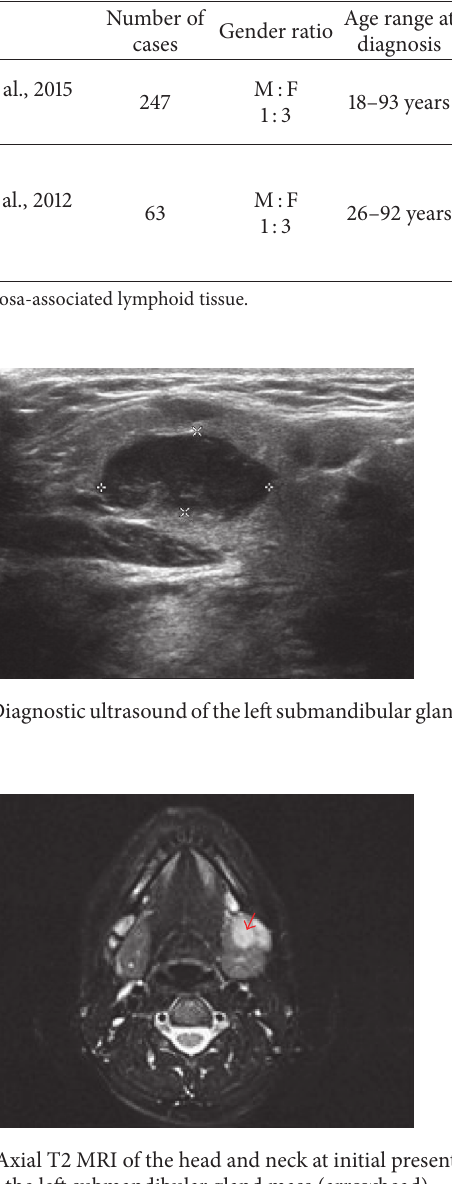
Table 1: Summary of published series on salivary gland lymphoma.